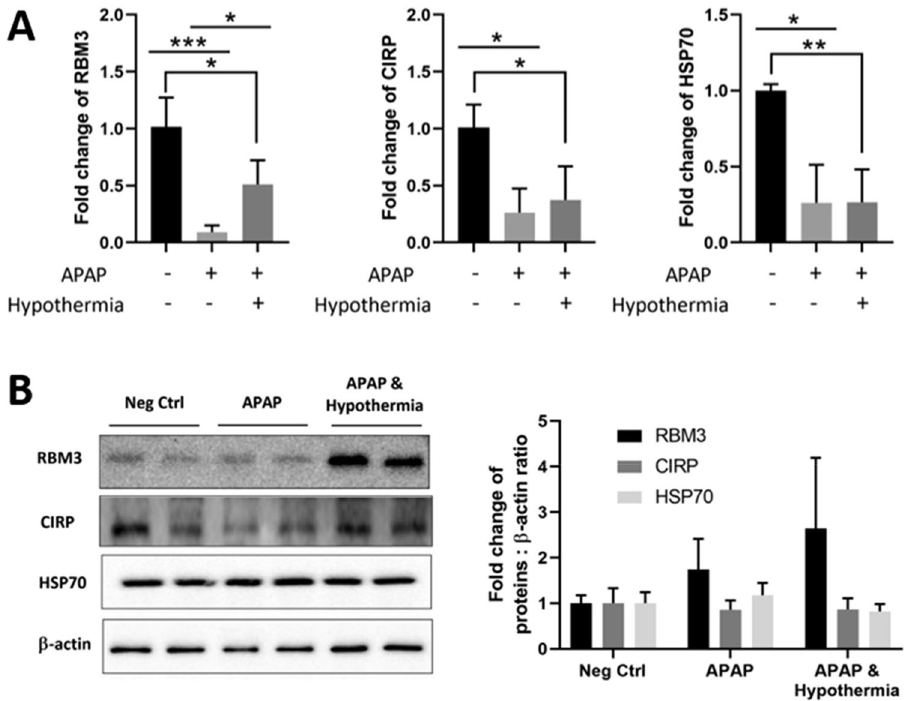
Figure 5. Effect of pulsed cooling on RBM3, CIRP and HSP70 expressions in mice. ( A ) transcript expressions of RBM3, CIRP and HSP70 were explored with real time RT-PCR and β-actin was used as the housekeeping gene. Thereafter, ( B ) western blotting was carried out to investigate the protein expressions of RBM3, CIRP and HSP70. β-actin was used as the housekeeping protein for all western blots. Densitometric analysis was performed with ImageJ and normalized against the negative control i.e. mice without both APAP administration and pulsed cooling. Data are presented as mean ± SD (n ≥ 3) where one-way ANOVA was used to make comparison across different treatment groups and post-hoc tests were subsequently carried out with correction for multiple comparisons using Sidak’s method. * P < 0.05; ** P < 0.01; *** P <